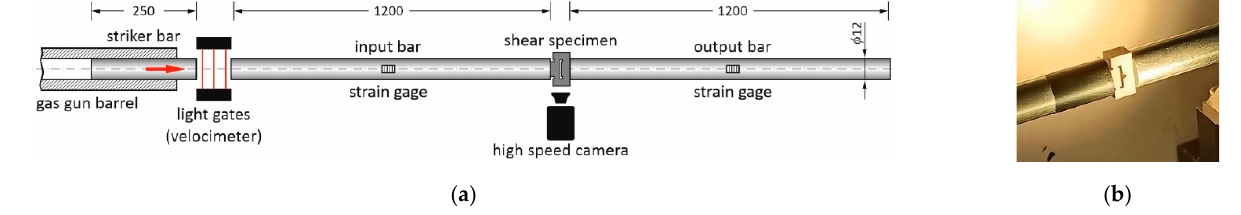
Figure 3. Scheme of the SHSB setup used in investigations ( a ); view of the D2S specimen placed between the SHPB bars ( b ).